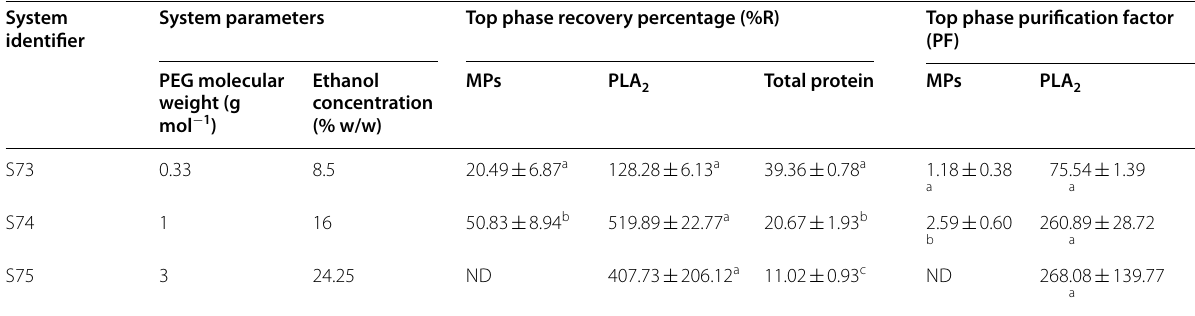
) using ethanol–potassium phosphate systems 2